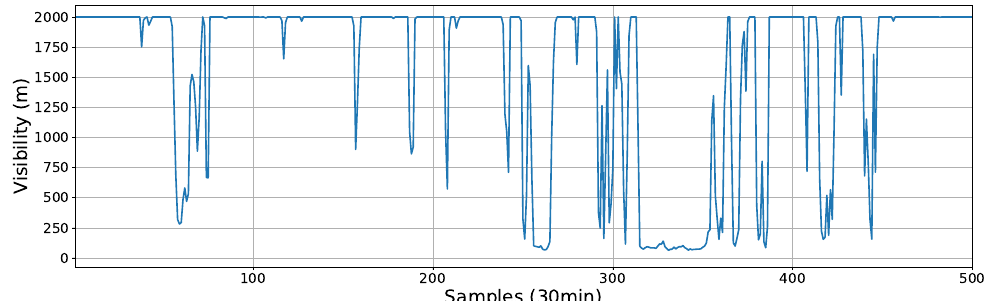
Figure 5. First 500 samples of the visibility time series, with a temporal resolution of 30 min, considered as target variable.